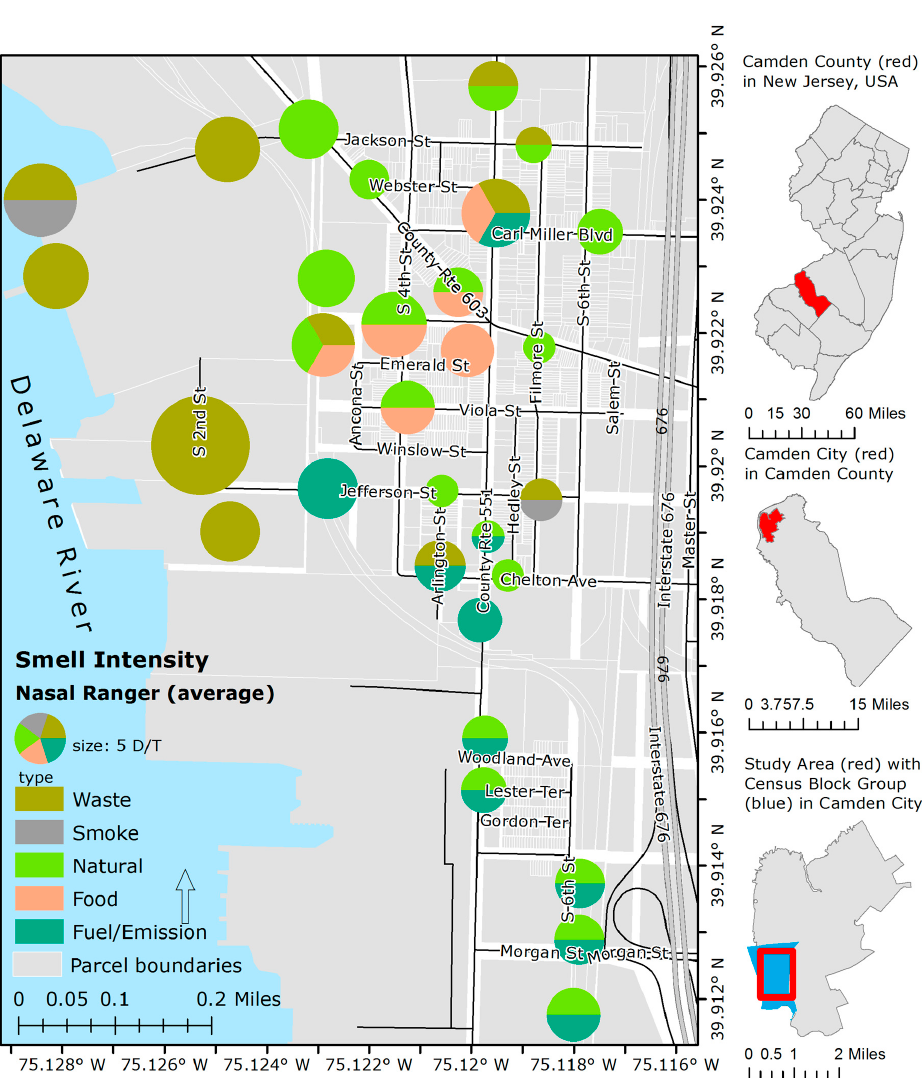
Figure 2. Sample of nasal ranger readings at Liney Ditch Park.